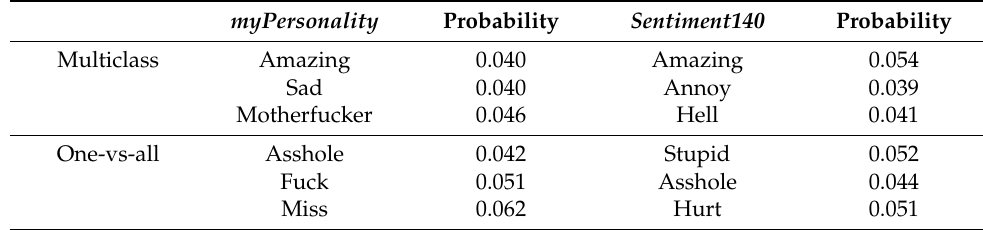
Table 8. Probability of top three seed words.